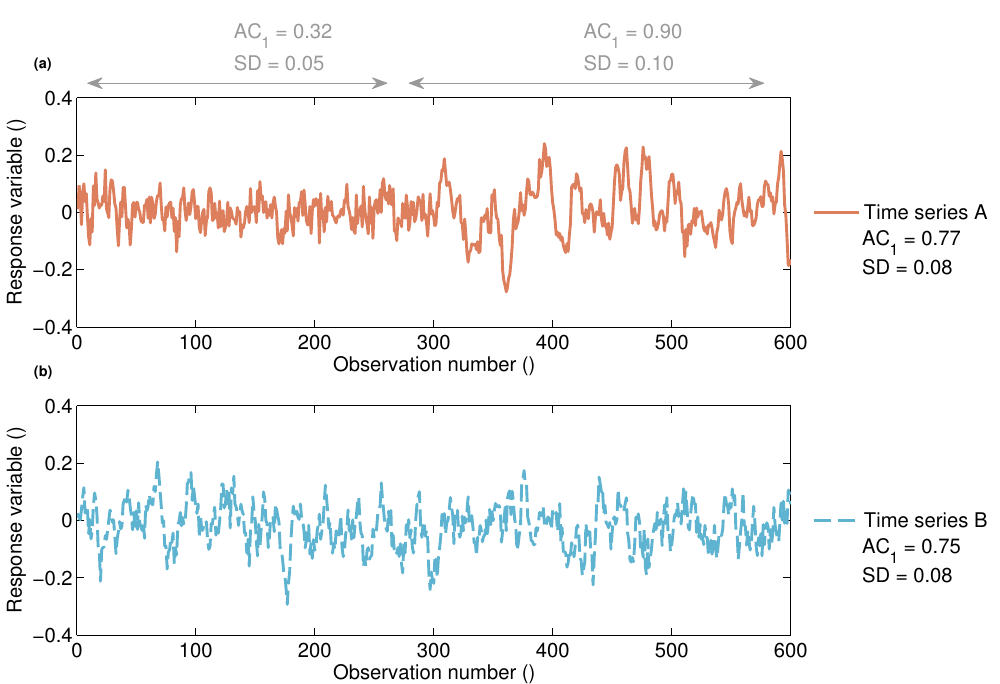
Figure 1. Proof of concept: two time series ( a , b ) (the y-axis represents a response variable (e.g., biomass or NDVI), and the x-axis represents the observation number of the time series, an indicator of time) having approximately the same standard deviation (SD) and auto-correlation at lag one (AC 1 ). Time Series A, however, shows a break-point in the two properties: the standard deviation increases from 0.05 to 0.10 and its autocorrelation from 0.32 to 0.90, while the SD and AC 1 approximately remains the same for time series B. This illustrates that metrics applied on the complete time series might fail to provide important information. Consequently temporal changes in stability metrics should be assessed to allow for a correct interpretation of the